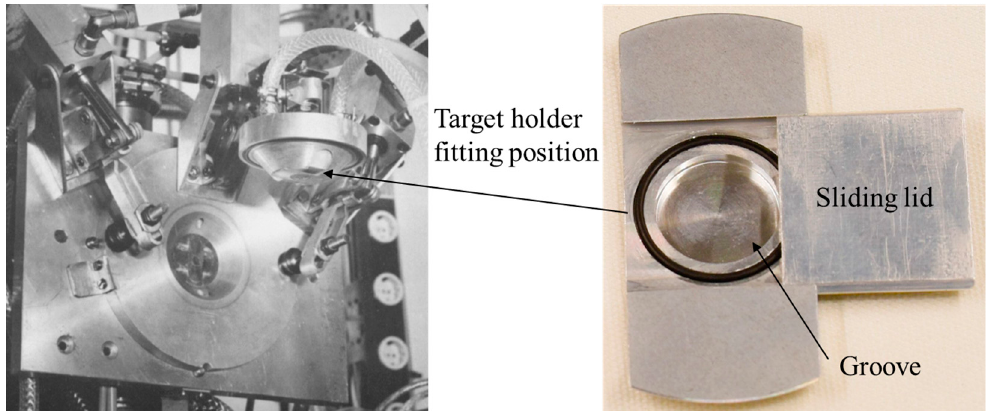
Figure 3. Photograph: An open view of the 4 π water-cooled target head at the Forschungszentrum Jülich, used for irradiation (after [37]). The Al target holder with a groove for inserting the 86 SrCO 3 pellet is shown on the right. The groove was closed by a sliding lid, and the target holder could be fitted in the target head. After irradiation, the target head was remotely opened, and the target holder fell in a lead pot.